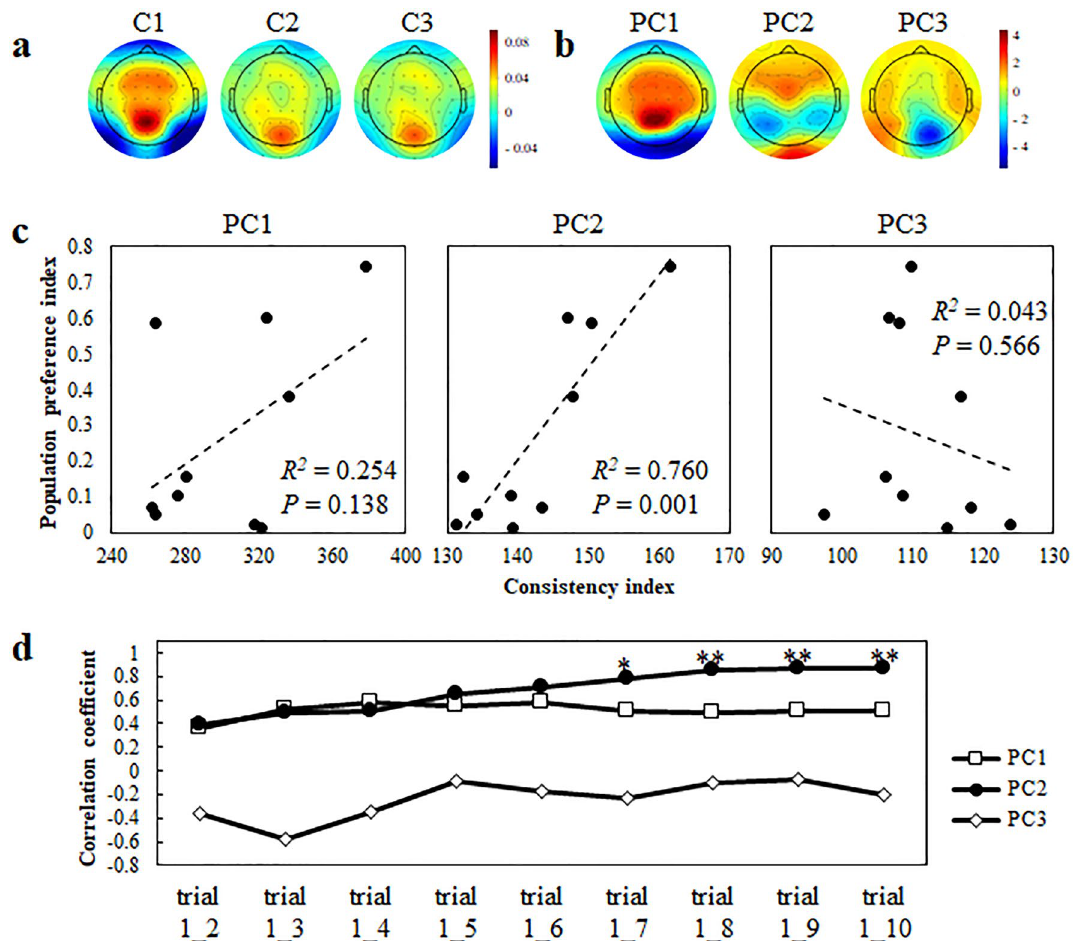
Figure 1. The relationship between PCA-based extraction of inter-trial consistency responses and population preferences. ( a ) Scalp topographies indicating canonical loadings (C1, C2, and C3) of the first three correlated components for the 3–80 Hz band when viewing the most popular TV commercial (i.e. the TV commercial with the highest population preference index in the stimuli dataset). The canonical loadings were computed for all paired 15-s (15,000 time points) trials and averaged across all participants, paired trials for each of the first three components. ( b ) Scalp topographies indicating the 1st, 2nd, and 3rd principal-component scores (PC1, PC2, and PC3, respectively) obtained from concatenated canonical loadings from all participants, paired trials and all of the first three components for the 3–80 Hz band when viewing the most popular TV commercial in the dataset. ( c ) Relationships between the population preference indices for ten TV commercials collected from a large audience and consistency indices representing the IP between the template PC score for the most popular TV commercial in the dataset and PC scores obtained similarly for each video. Dashed lines indicate the linear regressions between the indices. ( d ) Pearson correlation coefficients between the consistency indices and the population preference indices as a function of trial-pair datasets. The consistency index was computed using all possible trial pairs within the indicated trial number range. Bonferroni corrected, one-sided: * P < 0.05, ** P <